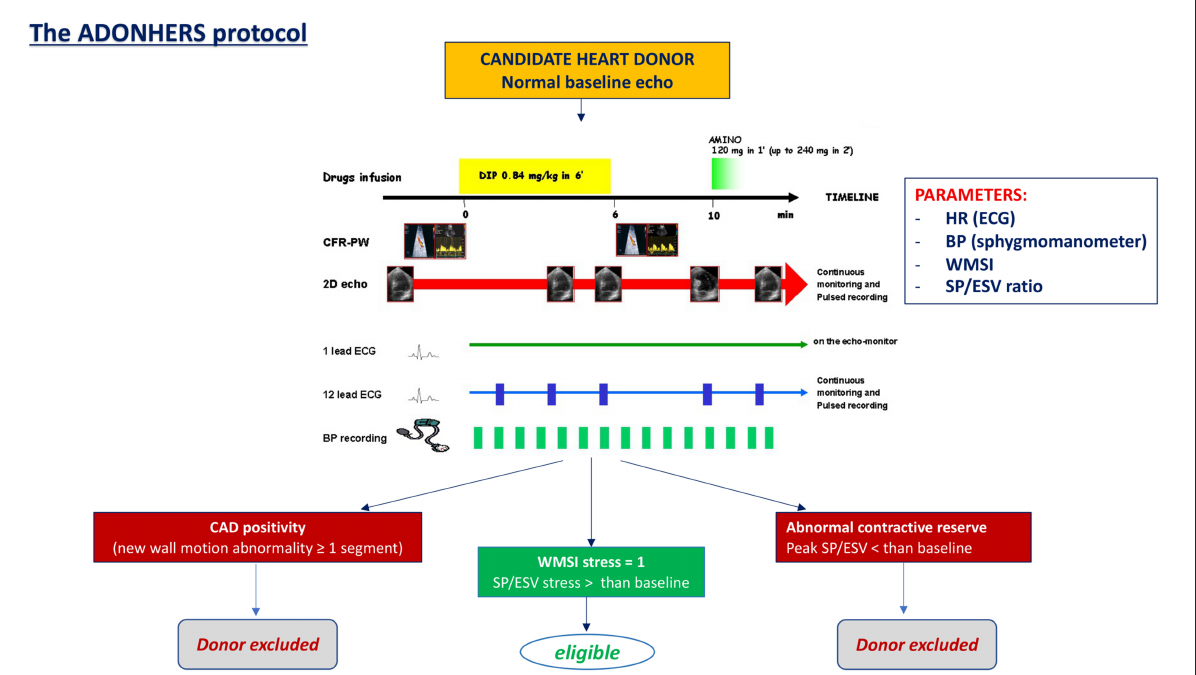
FIGURE1 The dipyridamole stress echo in the Adonhers protocol [adapted from Franchi et al. (14)]. When resting echocardiography was normal a pharmacological stress echo test was performed using dipyridamole (0.84 mg/kg in 6min). Three criteria of stress echo positivity were accepted a priori, excluding the heart from eligibility for donorship: (1) Regional wall motion abnormalities at rest or during stress. (2) A LV elastance falling during stress. (3) A submaximal stress halted due to non-diagnostic limiting effects before completion of the infusion, since a submaximal test dramatically lessens diagnostic and prognostic power. Accepting a heart was done in conformity with clinical and emergency criteria in use. BP, blood pressure; CAD, coronary artery disease; ECG, electrocardiogram; HR, heart rate; SP/ESV, systolic pressure/end systolic ratio; WMSI, wall motion score